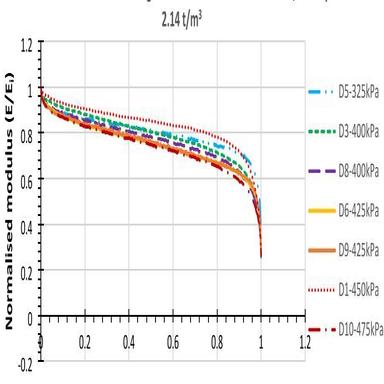
Normalised modulus degradation curves of an FBS mixture (2% bitumen and 2% lime).